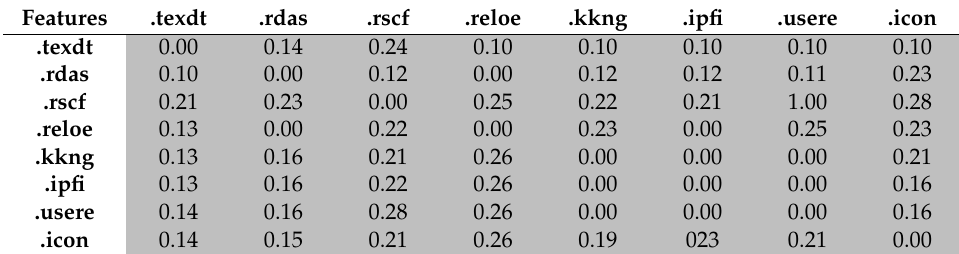
Table 5. Similarity matrix of the Trojan: Win32/Banload.A family.